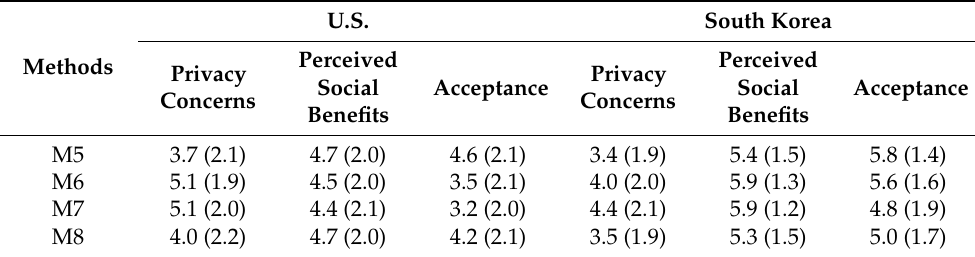
Table 6. Descriptive statistics of privacy concerns, perceptions of social benefits, and acceptance for the four self-quarantine monitoring methods. U.S. Methods